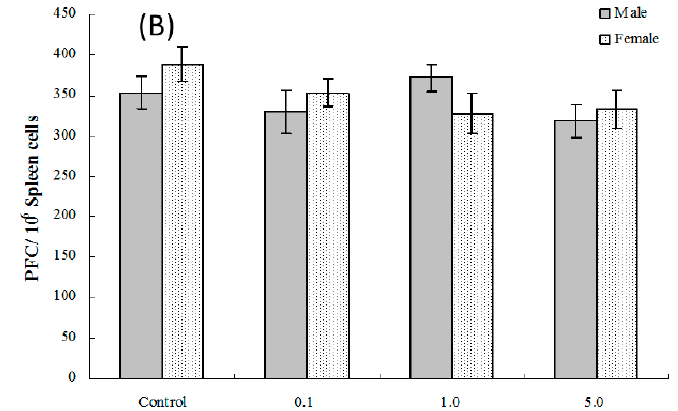
Figure 4. Plaque-forming cell (PFC) response by splenocytes from C57BL/6 mice exposed in utero to PFOS during GD 1–17. Cells obtained from mice at ( A ) four and ( B ) eight weeks of age. Data shown are the mean ± SEM. * Value significantly different from respective controls ( p ≤ 0.05) by the one-way ANOVA test. All PFC data were log-transformed prior to statistical analysis. n = 12 each group.